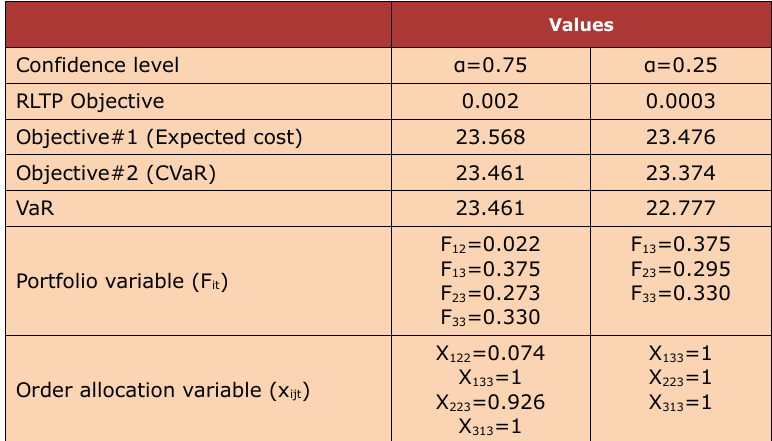
Table 13. The solution results for multi objective model by the selected